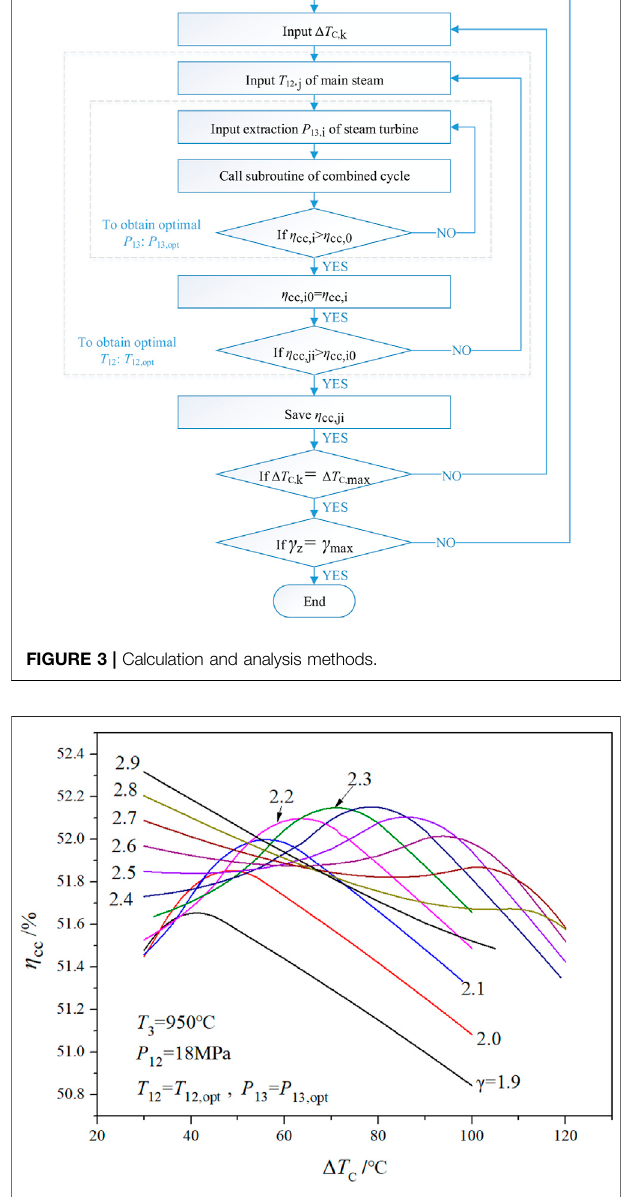
FIGURE 4 | Relationship curves of combined cycle ef fi ciency with cold end temperature difference and compression ratio.